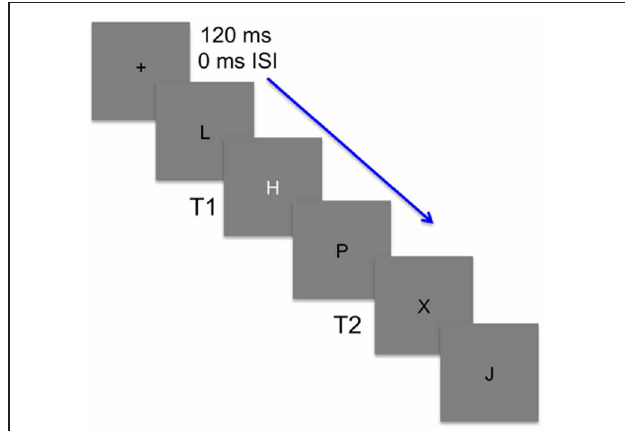
FIGURE 1 | An illustration of the stimuli used in the attentional blink task. Stimuli were presented at a rate of 120ms with no inter-stimulus interval (ISI). Participants were to first detect whether a white target (T1) was embedded among black distractors. T1 was either an H or S and on one-third of the trials was replaced by a black distractor. Participants then needed to detect a second target (T2) that randomly occurred 1–8 lags after T1 and was black like the distractors. T2 was present in every trial and was either an X or